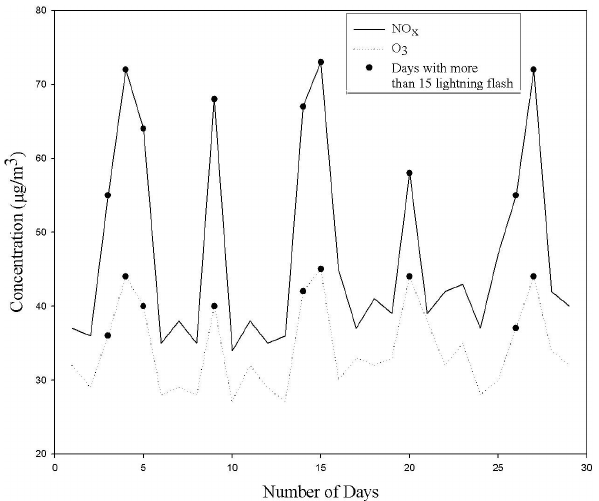
Figure 8. The variation of the daily average concentration of NO x and O 3 with lightning days (number of lightning flashes >15) and non-lightning days.